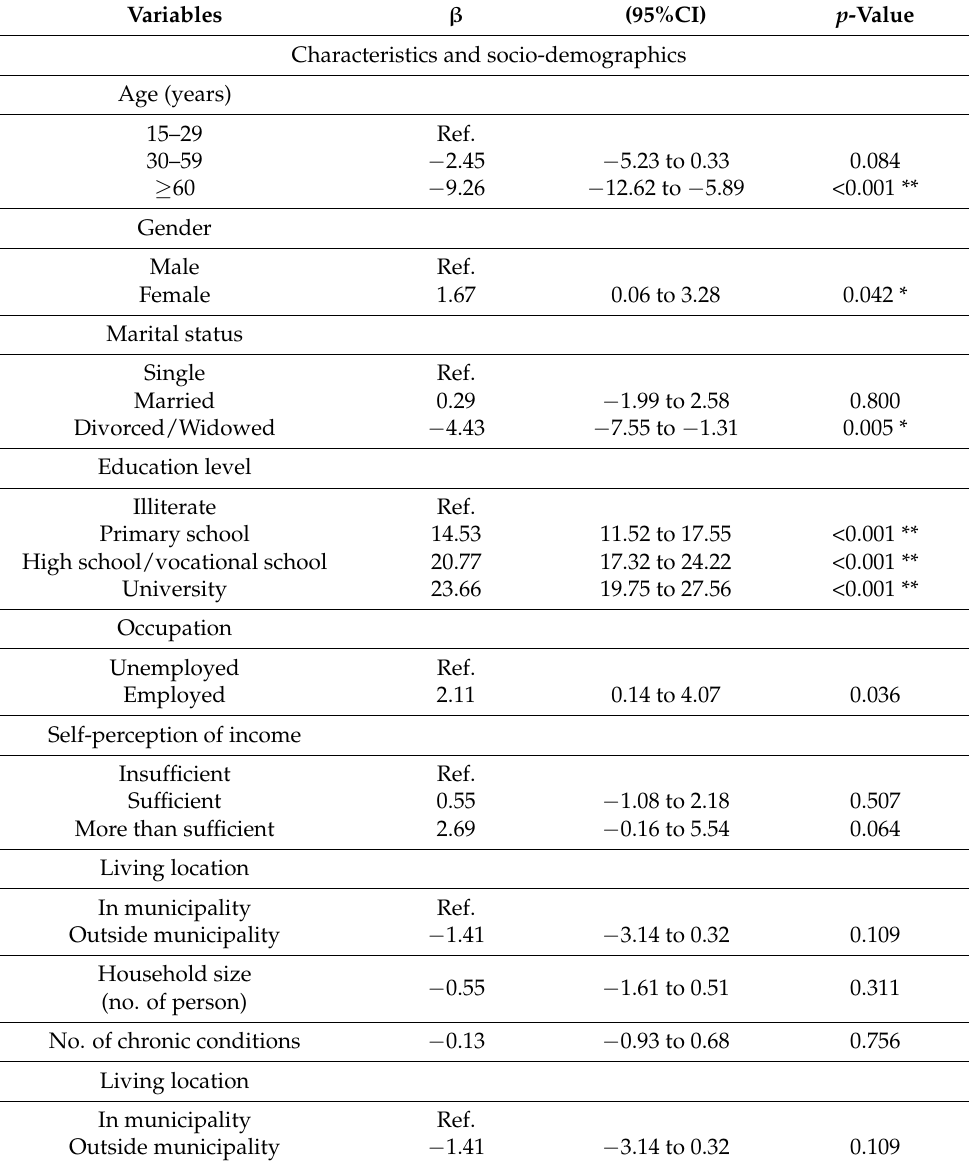
Table 3. The exploratory models of the factors associated with general health literacy. Variables β (95%CI) p